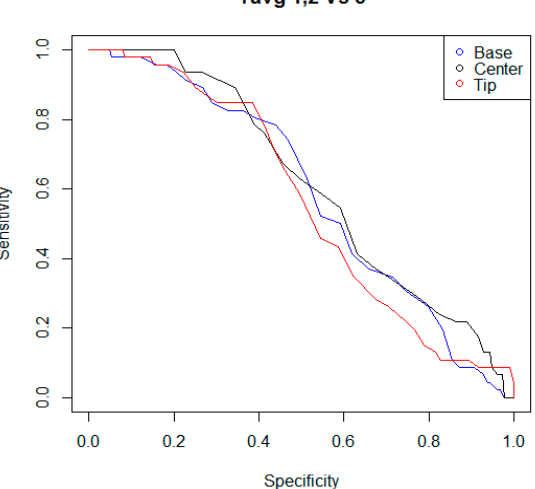
Figure 3. Receiver operating characteristic curves (ROC) curves of the statistical tests that were built considering the performances of the indicators T avg,B , T avg,C , and T avg,T , and different possible cutoff levels. The indicators T avg were the average surface skin temperatures measured by the thermal imaging camera in areas of rectangular shape, positioned at the base, at the center, and at the tip of each teat. Teat status was evaluated while considering digital pictures acquired within 30–60 s after the cluster removal. Through these digital pictures, color changes of teats, caused by a possible mechanical stress, were evaluated by a researcher adopting a scale that ranged between one to three. When teat scoring fell in the level “three” of the color change scale, the teat was considered as “mechanically